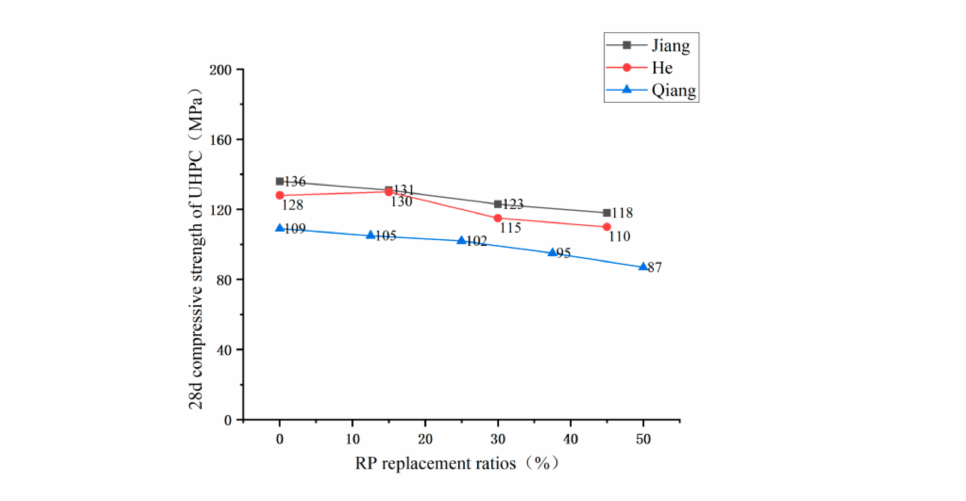
Figure 14. Compressive strength of UHPC under different replacement ratios of RP